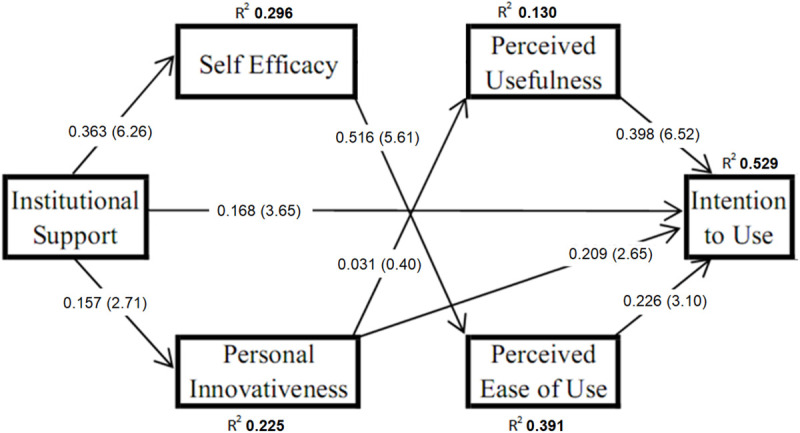
Structural model result.